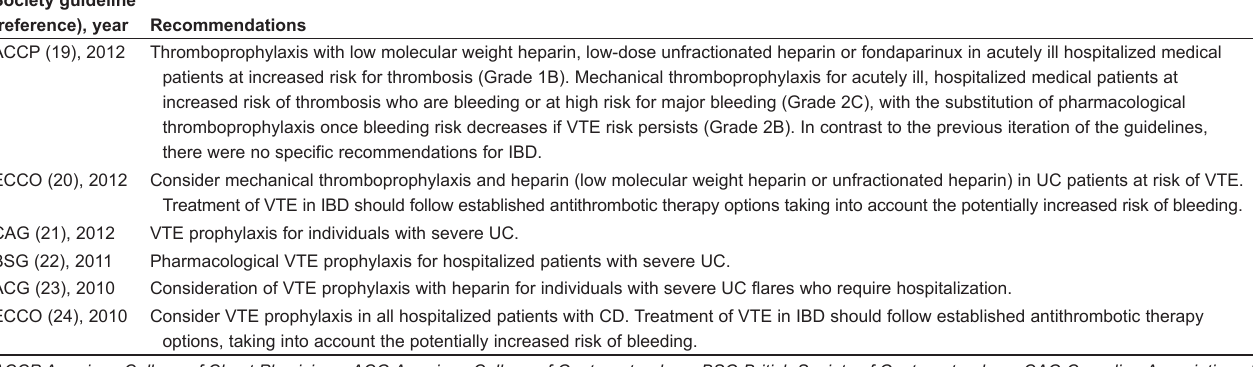
TAble 2 Summary of society guidelines for venous thromboembolism (VTe) prophylaxis in hospitalized inflammatory